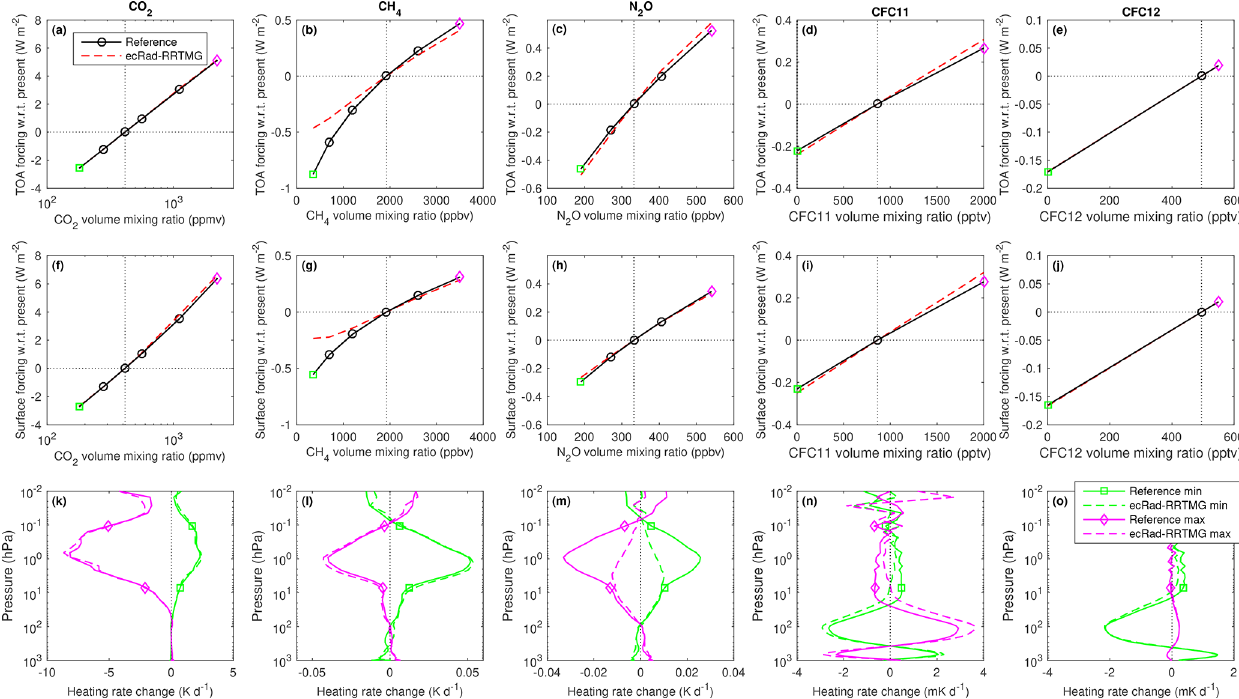
Figure 6. Comparison of reference LBL and RRTMG calculations of the instantaneous longwave clear-sky radiative forcing from perturbing each of the five well-mixed greenhouse gases from their present-day values, at (a–e) the top of the atmosphere and (f–j) surface, averaged over the 50 profiles of the Evaluation-1 dataset. Panels (k–o) show the mean change to heating rate resulting from perturbing the concentration of a gas from its present-day value to either the maximum or minimum value in the range shown in Table